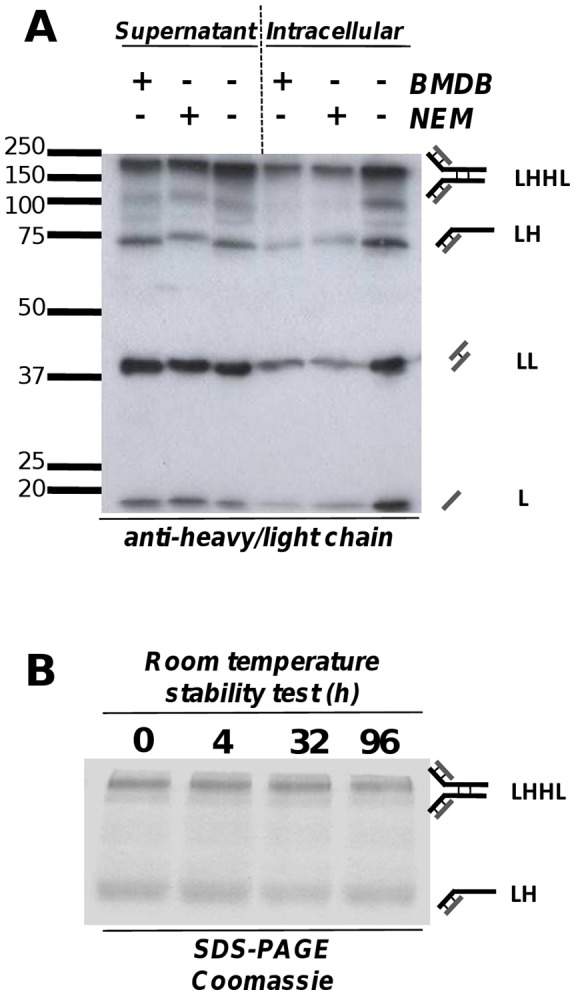
Origin of the HL species.
A. Treatment of 2N2 samples with oxidising agents does not alter the ratio of half-antibody to full mAb. BMDB (1,4-bismaleimidyl-2,3-dihydroxybutane), NEM (N-ethylmaleimide), LHHL (assembled antibody), LH (half antibody species), LL (light chain dimer), L (light Chain). B. In cell culture supernatants the ratio of half- to full antibody does not change upon prolonged incubation at room temperature. Both analyses indicate that the half antibody species does not result from decay of the full antibody.